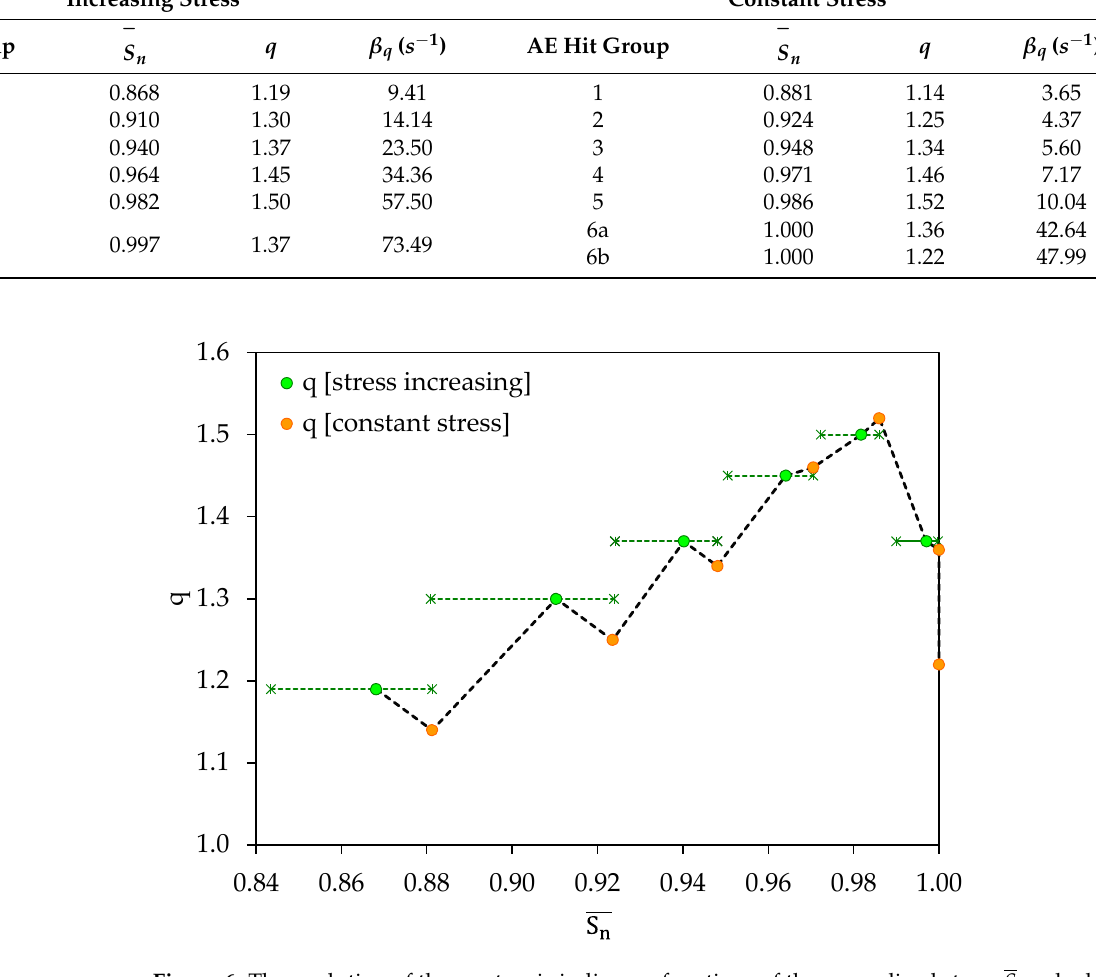
Figure 6. The evolution of the q entropic indices as functions of the normalized stress S n calculated for the UCSS loading protocol.